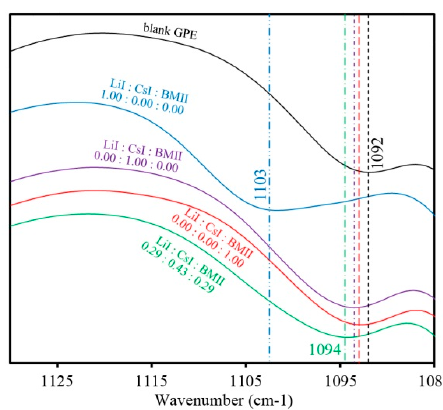
Figure 5. FTIR spectra of selected PhCh–(LiI:CsI:BMII) GPE samples for the ether absorption bands ranging from 1085 to 1130 cm − 1 .